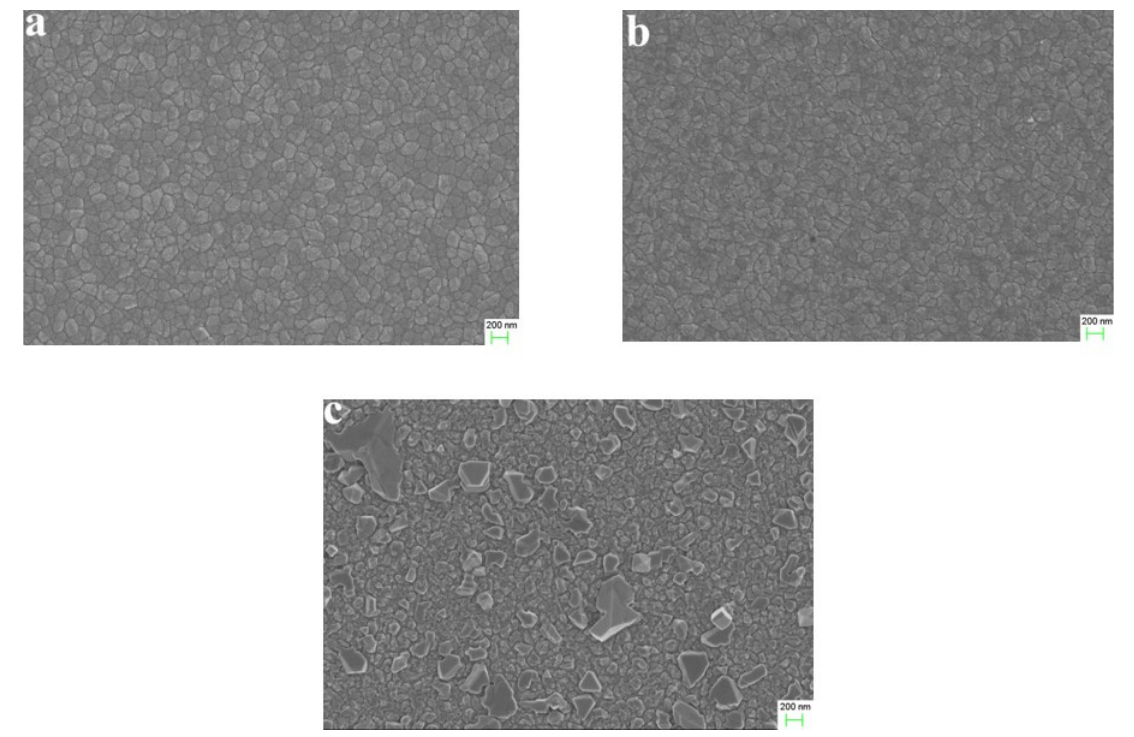
Figure 4. SEM images of the precursor layer cooled down from the temperature-rise period. ( a ) Sur- face morphology of structure 1, ( b ) surface morphology of structure 2, ( c ) surface morphology of structure 3.